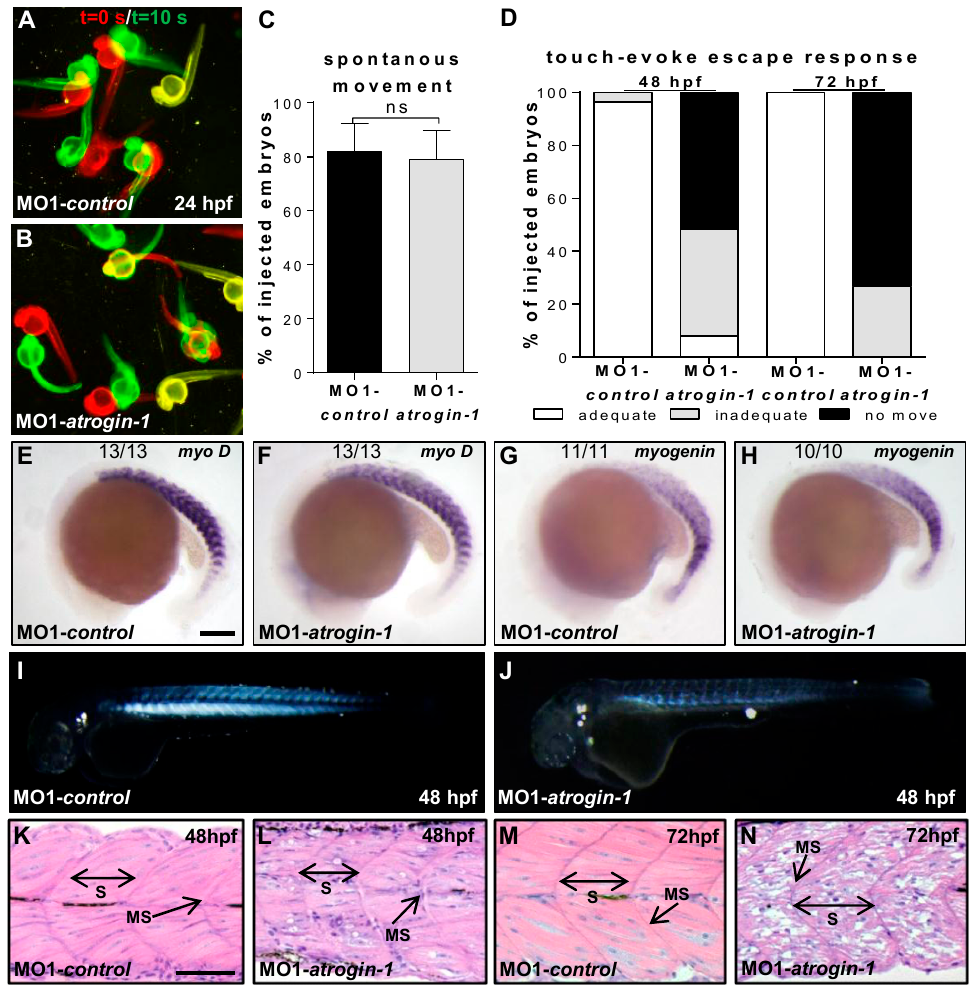
Figure 3. Myopathic phenotype in Atrogin-1 knock-down embryos is progressive. ( A , B ) Spontaneous movement assay with false-colored superimposed overviews of 24 hpf control ( A ) and Atrogin-1 morphants ( B ); red pictures = 0 s; green pictures = 10 s; yellow = merge; ( C ) Statistical analysis of spontaneous movement assay, data represent means ± SD, student’s t -test p -value < 0.27, ns = not significant; ( D ) Quantification of touch-evoke flight response of 48 hpf and 72 hpf MO1- control and MO1- atrogin-1 injected embryos; ( E – H ) Lateral view of whole-mount antisense RNA in situ hybridization against myoD at 18-somite stage ( E , F ) and against myogenin at the 16-somite stage ( G , H ) scale bar = 100 µm. Expression of MyoD and myogenin is unaltered in Atrogin-1 morphants; ( I , J ) Lateral view of MO1- control ( I ) and MO1- atrogin-1 injected embryos ( J ) showing birefringence at 48 hpf; ( K – N ) H&E-stained sagittal histological sections of skeletal muscle at 48 and 72 hpf. S = somite, MS = myoseptum, arrow indicate somite borders, scale bar = 50 µm.